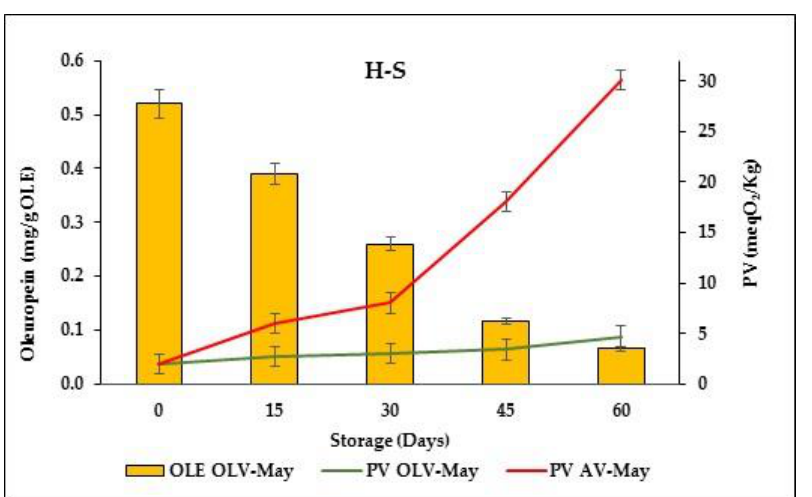
Figure 3. Variation of the oleuropein (OLE) content and peroxide value (PV) measured at 40 °C for 2 months in the mayonnaise samples prepared with olive leaf vinegar (OLV-May) and alcoholic vinegar (AV-May). The data are the means ± standard deviation of triplicate measures.